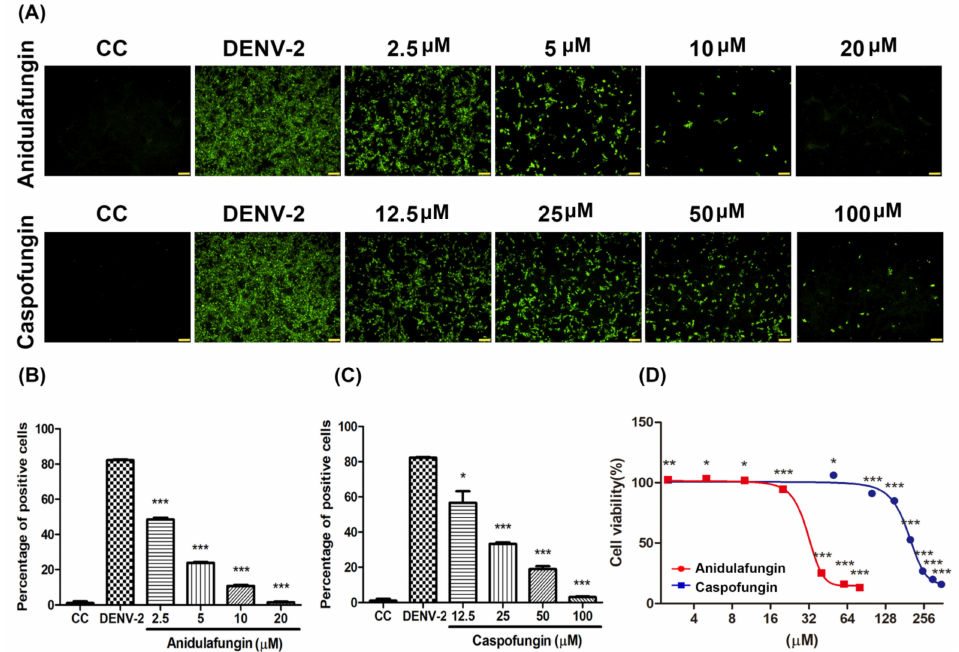
Figure 5. Anti-DENV-2 activity of anidulafungin and caspofungin, as determined using ( A ) IFA; ( B , C ) and ImageJ software. ( D ) Cell viability of anidulafungin and caspofungin. All data were obtained from at least three independent experiments, where significance was indicated as follows: